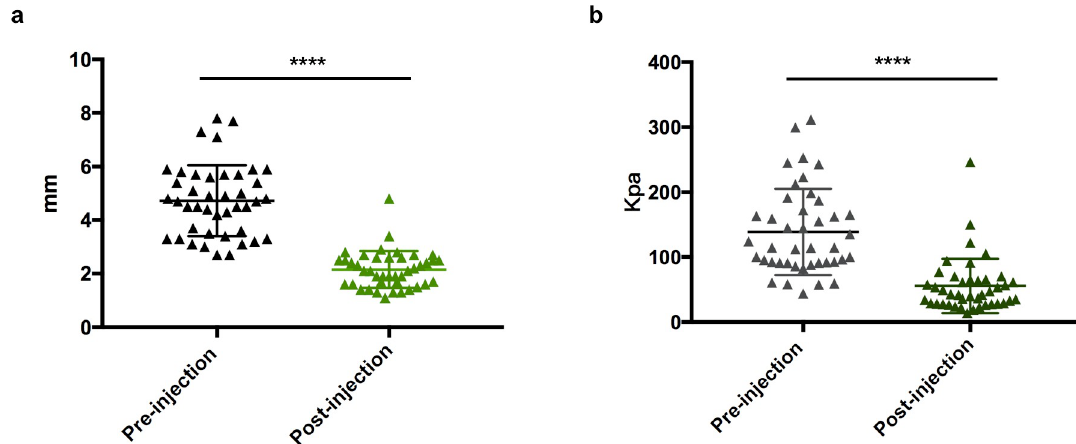
Fig 2. The effect of TAC+5-Fu injection therapy. TAC+5-Fu injection reduced (a) thickness and (b) elastic modulus of keloids measured by Doppler ultrasound. ���� p < 0.0001.